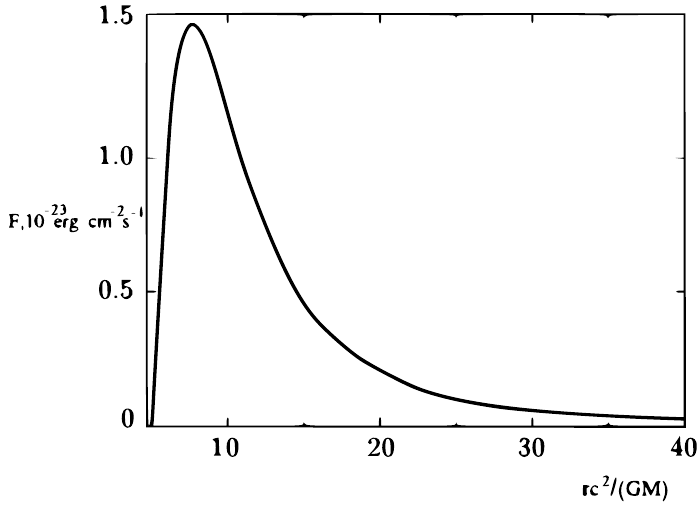
Figure 7. The energy flux from an accretion disk around a BD-wormhole. Reproduced from